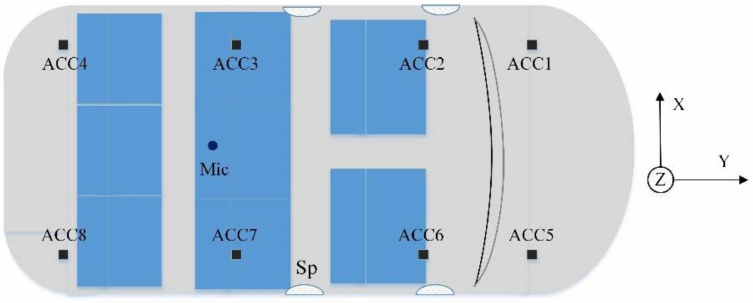
Figure 5. The installation positions of accelerometers and error microphone on the car.